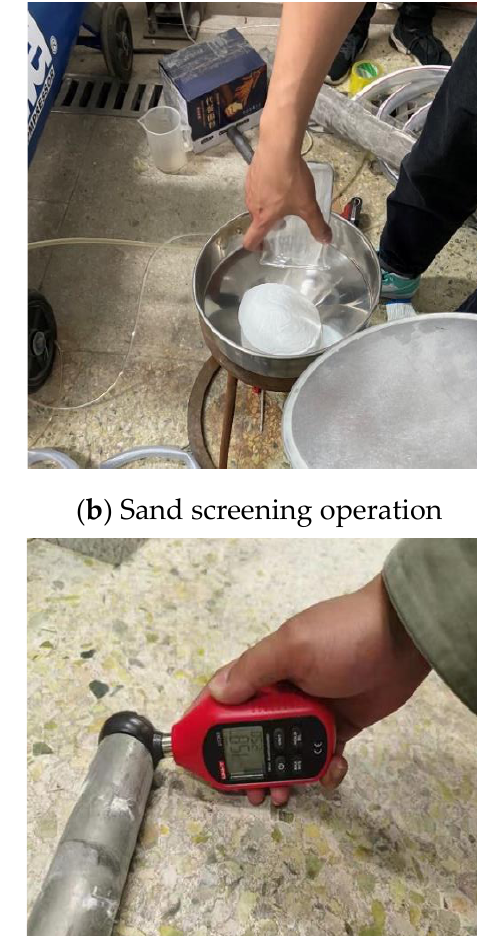
Figure 3. Screen and quartz sand used in the experiment.